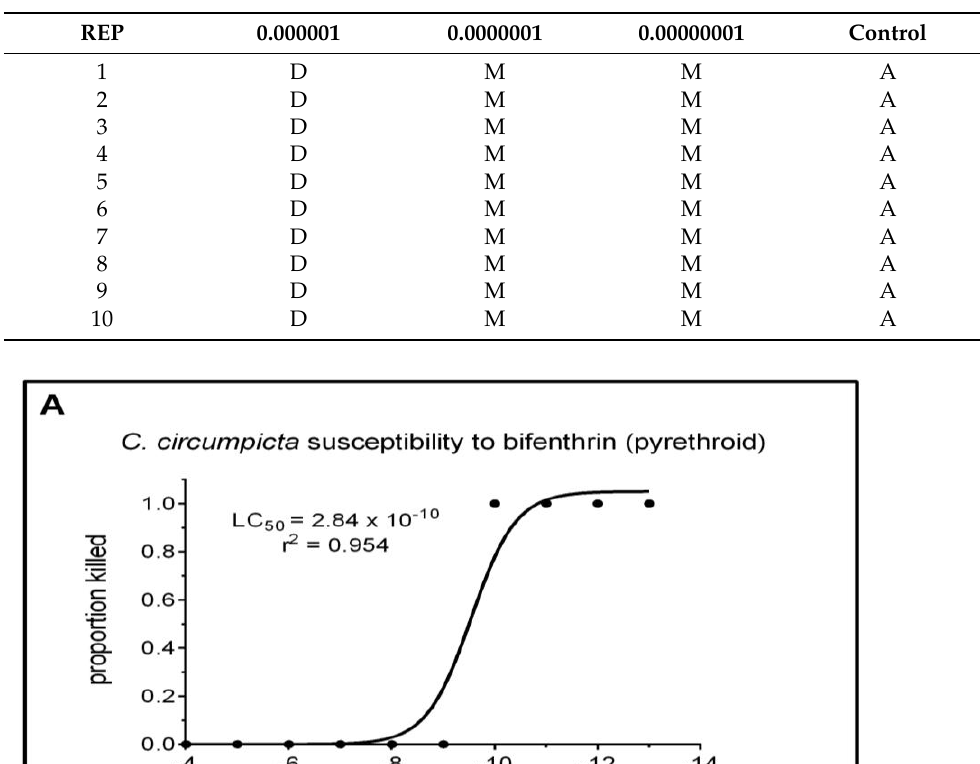
Table 2. Bifenthrin w/ C. circumpicta larvae. Dilutions mixed at 1 mg/1 mL stock solution. Ten repetitions with control (acetone) at stimulation. D = Dead; A = Active; M = movement with stimulation. LD 50 = 10 − 6 mg/mL.